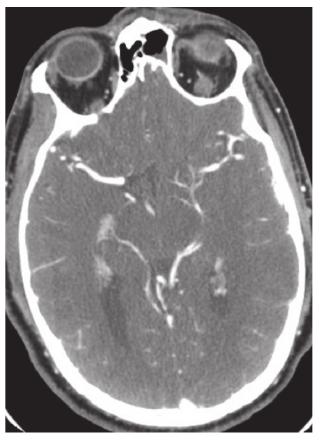
Figure 1: CT angiogram sequence of the left middle cerebral artery at the bifurcation with narrowing.